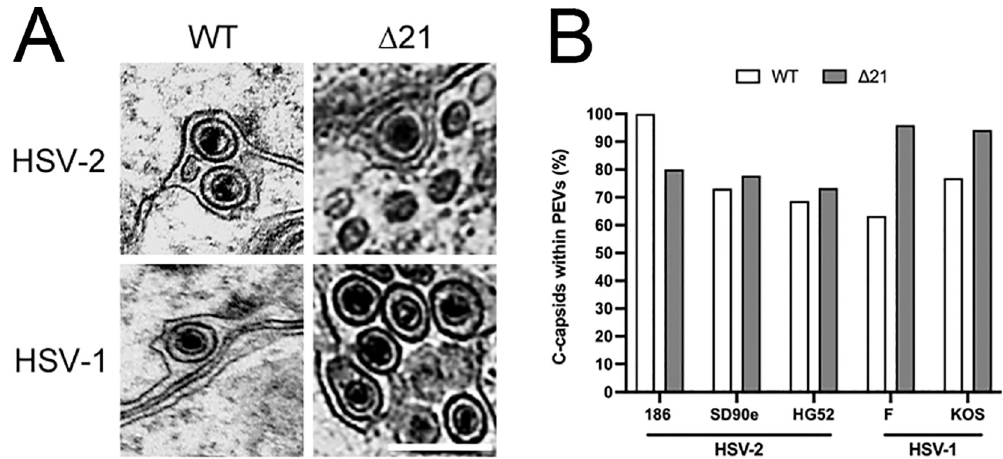
Fig 3. Perinuclear C-capsid abundance in HSV WT and Δ 21 infected cells. Vero cells were infected with HSV-1 or HSV-2 WT strains or their corresponding Δ 21 mutants at an MOI of 3 for 18 h. Cells were then fixed and prepared for TEM. Micrographs for each strain of HSV-1 and HSV-2 were obtained to quantify WT and Δ 21 capsids within PEVs. A) Examples of micrographs containing PEVs derived from HSV-2 SD90e WT and its Δ 21 mutant and HSV-1 F WT and its Δ 21 mutant. The scale bar shown is 500nm and applies to all panels. B) The quantification of C-capsids within PEVs from cells infected with HSV WT and Δ 21 strains (n = 11–27 micrographs per condition). A total of 7–158 PEVs were analyzed per condition. Statistical analysis was not possible due to PEVs being a transient assembly intermediate and not consistently present within each